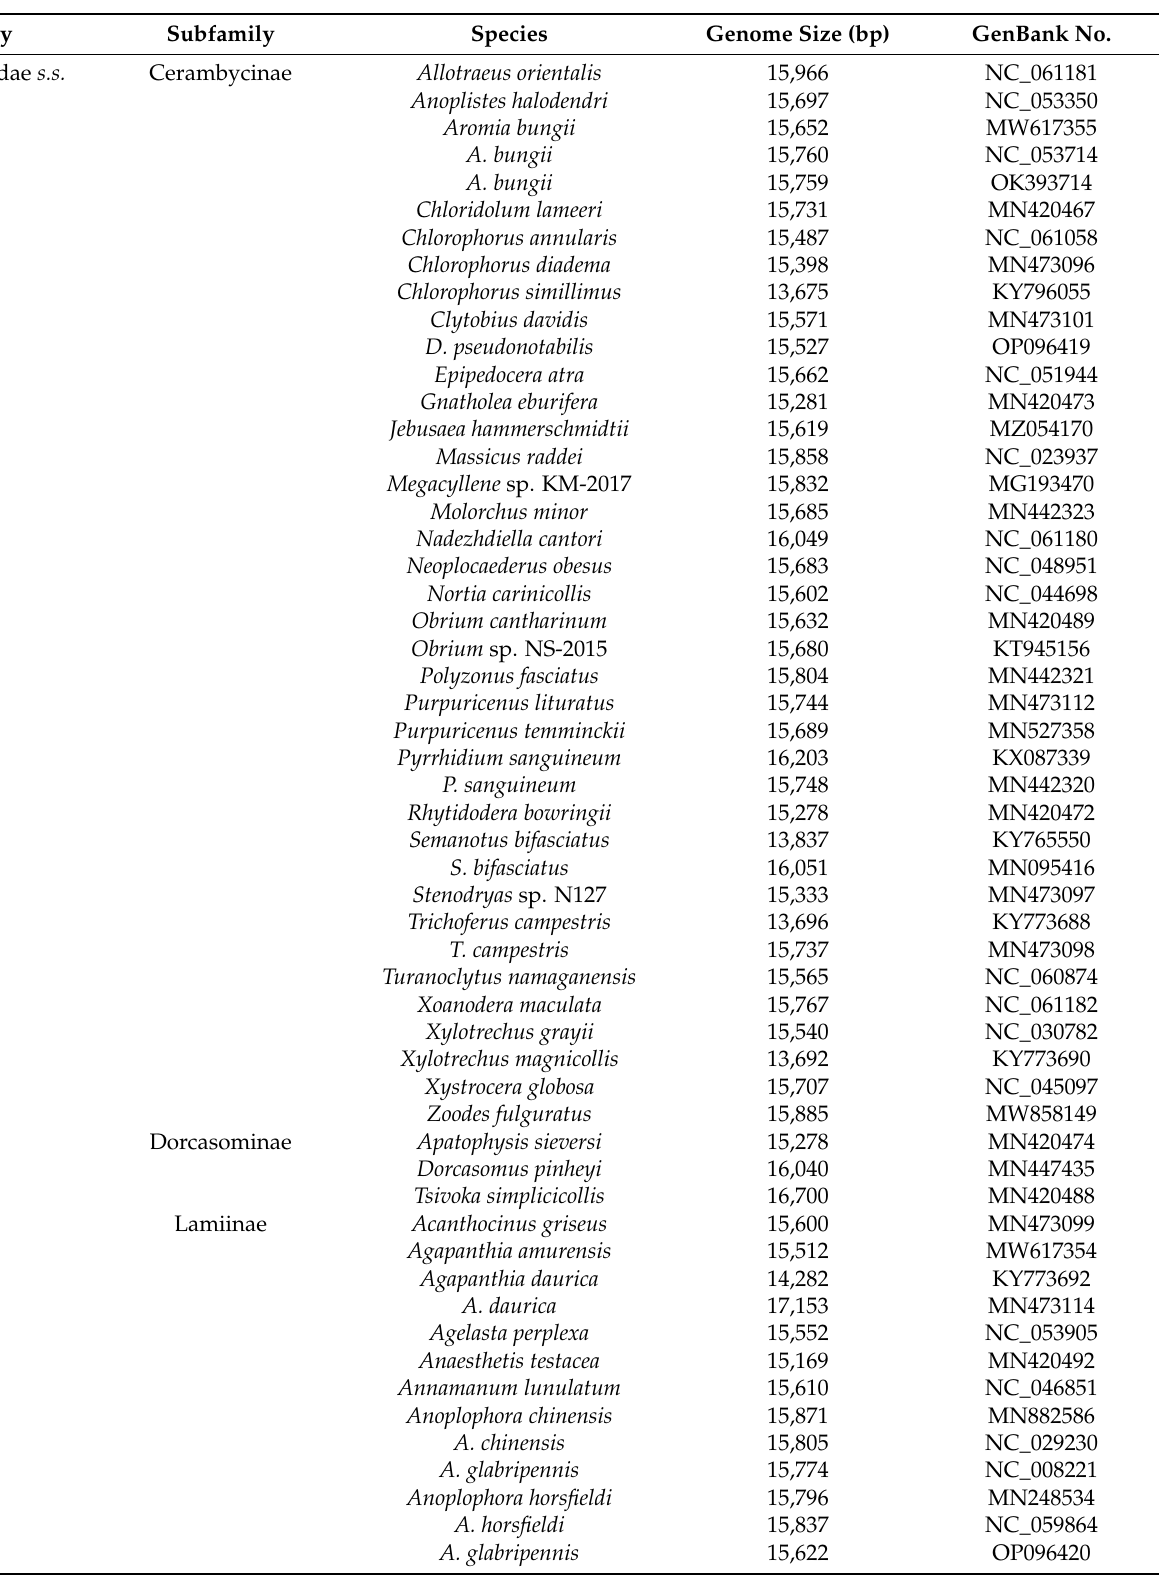
Table 1. Species used in this